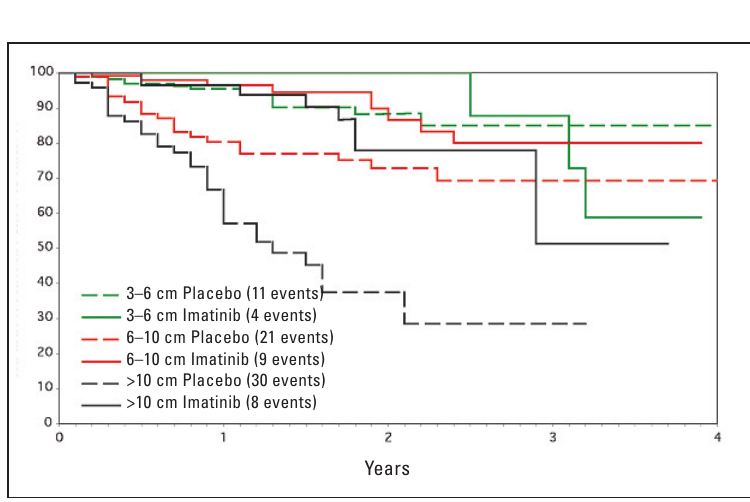
Figure 1 Recurrence-free survival and primary tumour size after complete surgery and adjuvant imatinib vs placebo for one year after resection. Z9001 interim data of 708 patients [from 88] (size 3–6 cm: p = 0.15; size 6–10 cm: p = 0.01; size >10 cm: p <0.001).